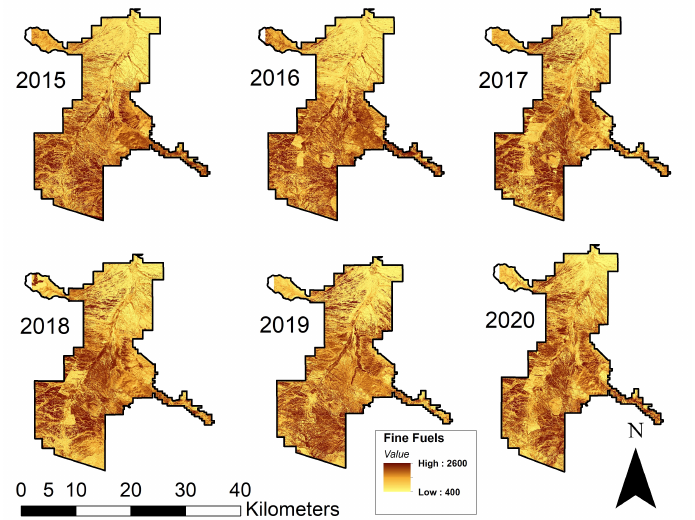
Figure 4. Serial model of fine-fuels (kg/ha) estimated from 2015 to 2020 with Sentinel-2A imagery across BANWR.